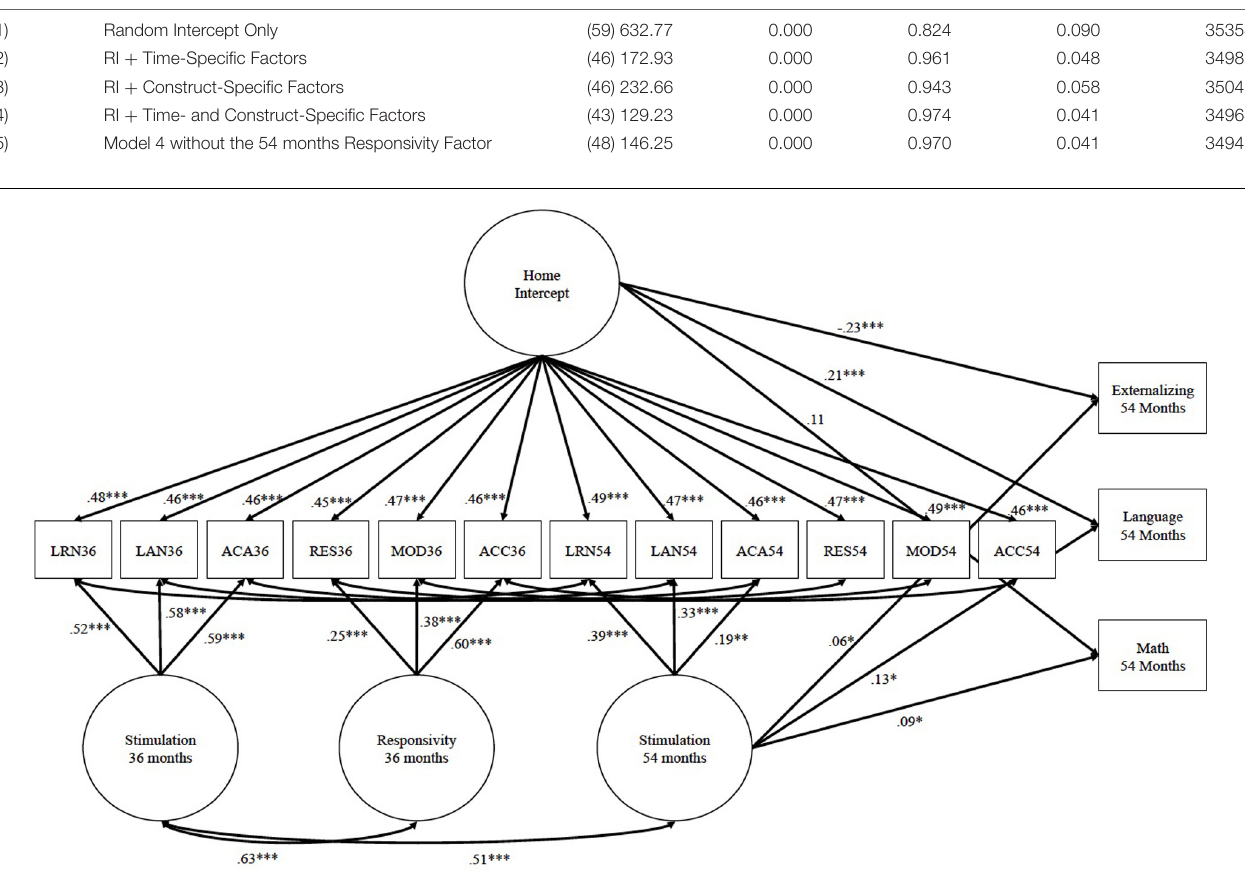
FIGURE 1 | Associations between home factors and children’s math, language, and externalizing. All estimates are standardized. Control variables include: gender, race, whether the father was in the home, family income, mother vocabulary, mother education, externalizing behaviors at 24 months, mental development index at 24 months, and vocabulary skills at 24 months. ∗ p < 0.05, ∗∗ p < 0.01, and ∗∗∗ p <